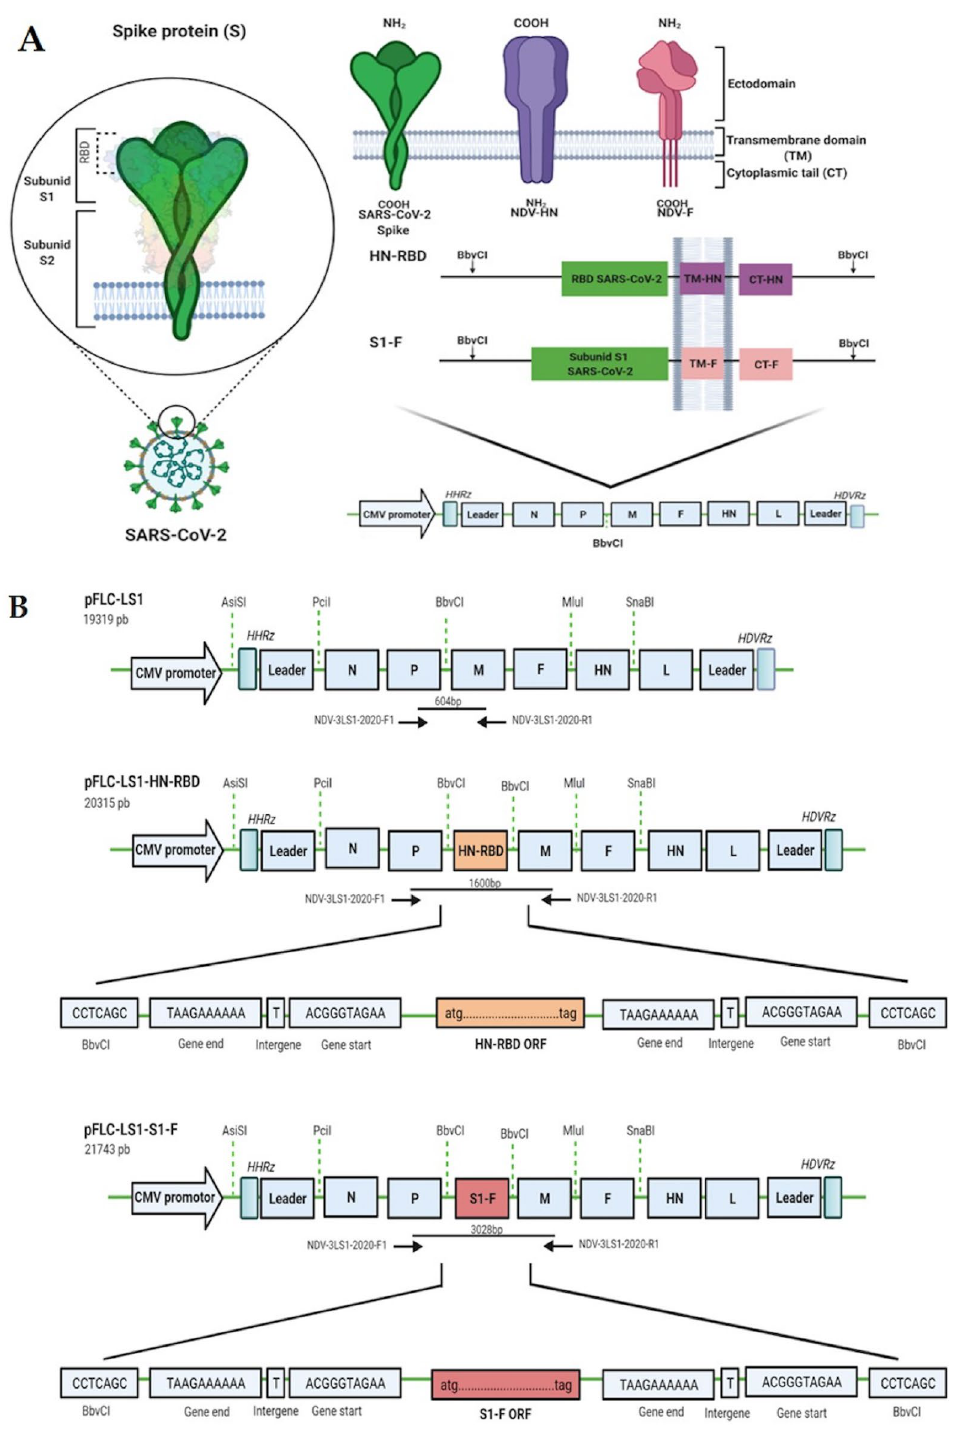
Figure 8. The strategy used for the generation of the recombinant NDVs expressing SARS-CoV-2 RBD and S1. ( A ) The schematic representation of the strategy of construction of the recombinant NDVs. Two transcriptional cassettes were designed for expressing RBD and S1: 1) HN-RBD was fused with the complete transmembrane domain (TM) and the cytoplasmic tail (CT) of the haemagglutinin–neuraminidase (HN) gene, 2) S1-F was fused with the TM/CT of the fusion (F) gene from the full-length pFLC-LS1. ( B ) The full-length anti-genome of NDV strain LaSota clone (pFLC-LS1) was used as a backbone clone, the pFLC-LS1-HN-RBD and pFLC-LS1- S1-F were generated from cassettes expressing RBD and S1 genes inserted into NDV genome under control of transcriptional gene end (GE) and gene start (GS) signals. The names, position, and direction of the primers used are shown with arrows (blacks) indicating the size